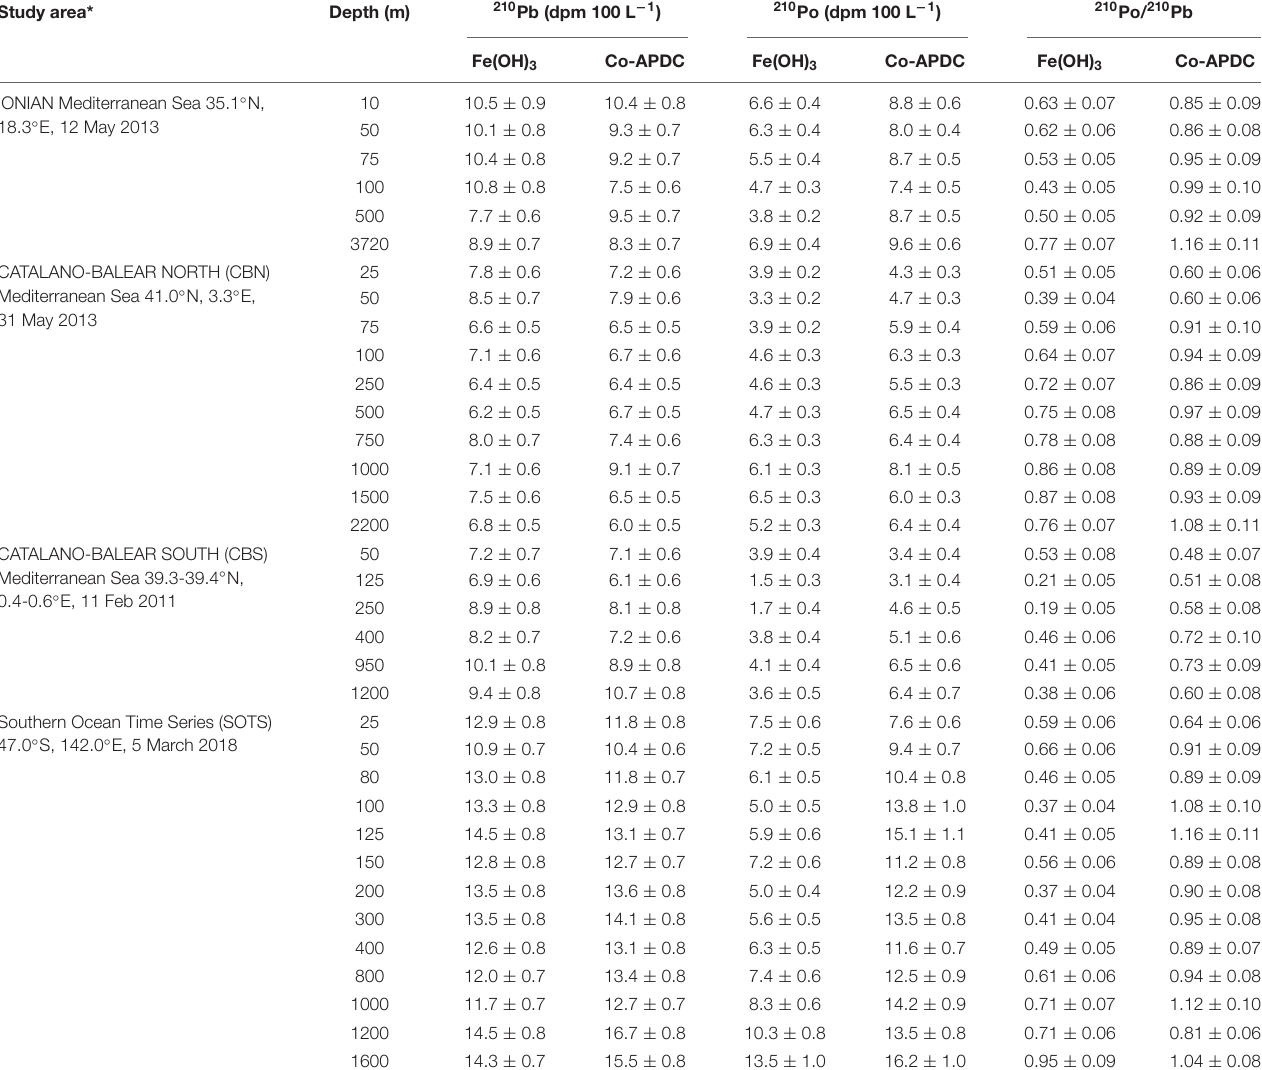
TABLE 1 | Total 210 Pb and 210 Po activities and 210 Po/ 210 Pb activity ratios measured using the Fe(OH) 3 and Co-APDC precipitation methods [Fe(OH) 3 TOT siph and Co-APDC TOT protocols in Figure 1 ] in four duplicate ocean